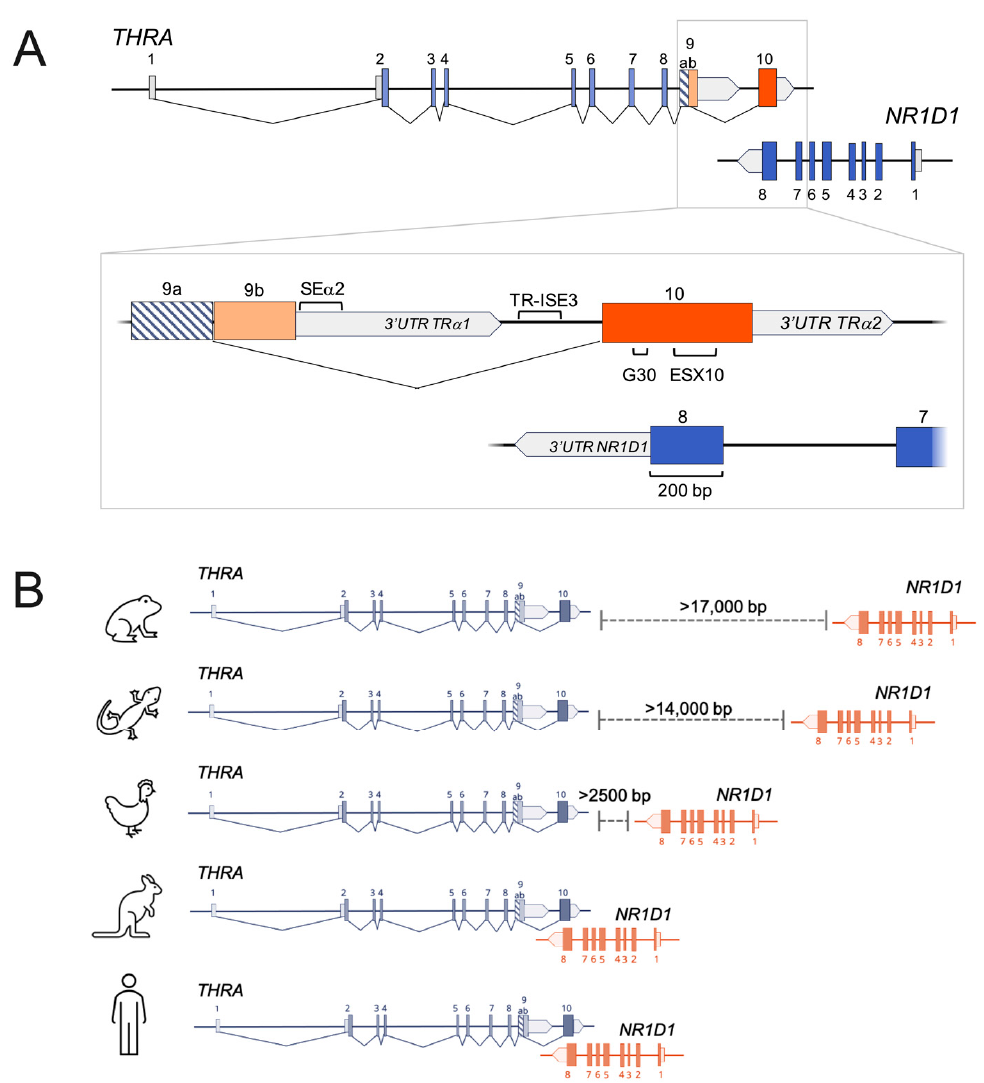
Figure 3. Alternative splicing of THRA and overlap with NR1D1 . ( A ) Antisense overlap of THRA with NR1D1 results in a 200 bp-long bidirectional coding sequence in exon 10 of THRA and exon 8 of NR1D1 . Several sequences important for alternative splicing of THRA have been identified. The splicing enhancer α 2 (SE α 2) is located directly downstream of exon 9 in the 3 ′ untranslated region (UTR) of TR α 1, while the intronic splicing enhancer TR-ISE3 lies between the 3 ′ -UTR of TR α 1 and exon 10 of TR α 2. The guanine-rich element G30 and ESX10 (exonic splicing enhancer in exon 10) map directly to the coding sequence of exon 10. ( B ) Evolution from distal convergent transcription in non-mammals (e.g., amphibians and reptiles) to bidirectional overlapping transcription in mammals (e.g., marsupials and humans).